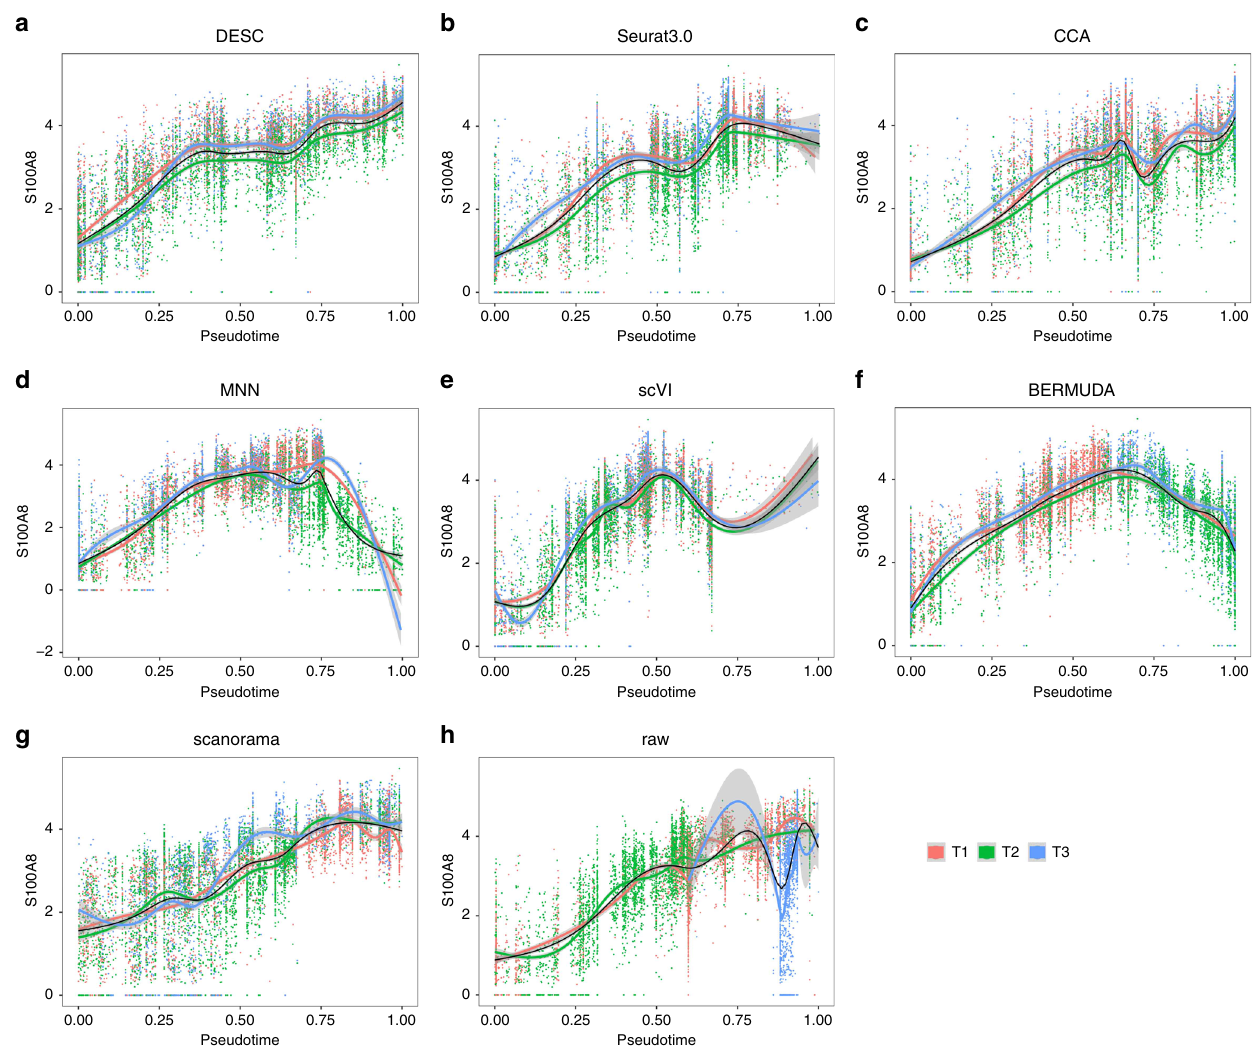
Fig. 8 The expression of marker gene S100A8 (classical monocytes) over pseudotime for different methods for cells across batches. The black line is the smoothed expression curve when cells from all batches are included. The red, green, and blue lines are the smoothed expression curves for cells from T1, T2, and T3, respectively. Pseudotime from all methods was scaled to [0, 1] for comparison. a Low-dimensional representation from DESC as input; b CCA components from Seurat 3.0 as input; c CCA components from method CCA as input; d PCA components of corrected gene expression values from MNN as input; e low-dimensional representation from scVI as input; f low-dimensional representation from BERMUDA as input; g low-dimensional representation from scanorama as input; h raw gene count matrix as